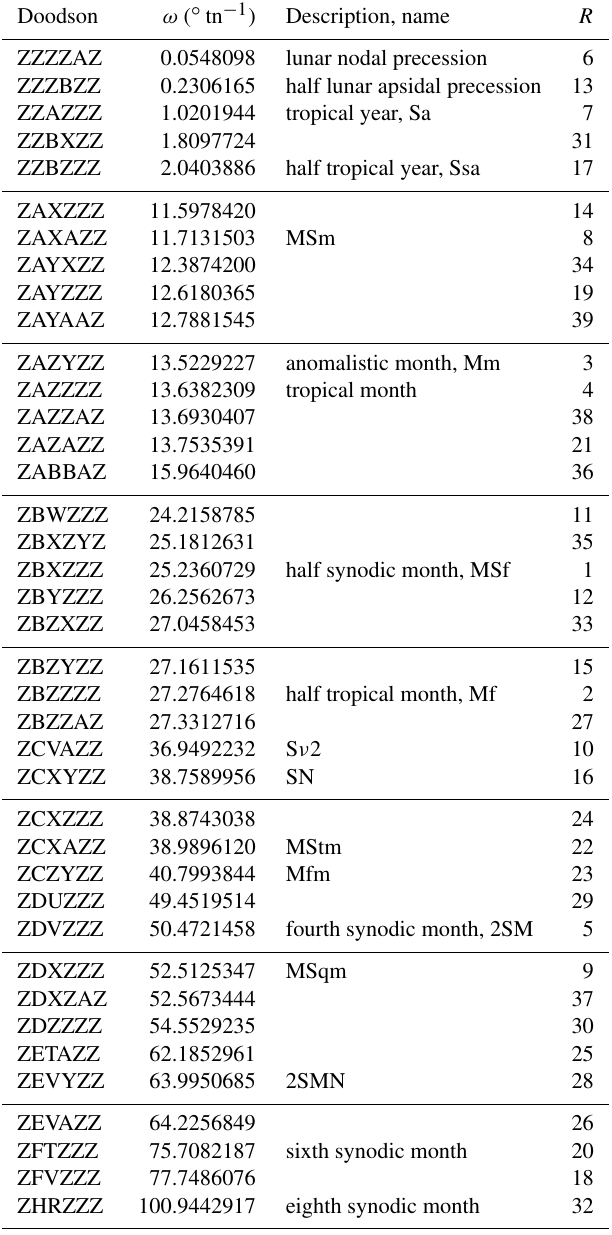
Table 4. The modified and adopted new list of long-period partial tides. The rank R indicates the importance of a partial tide for tidal analysis, based on the combined evaluation of data from all tide gauges.